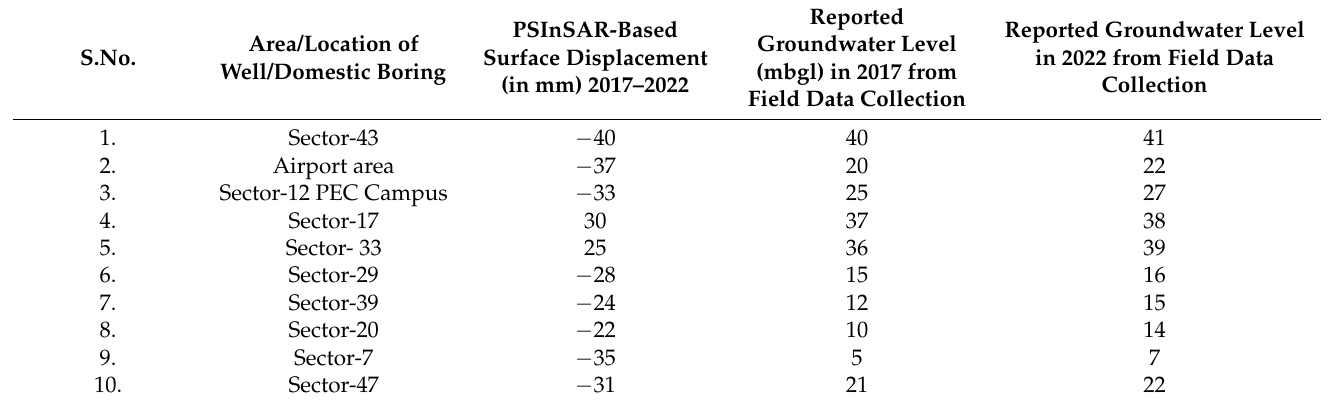
Table 2. Groundwater data from field and surface